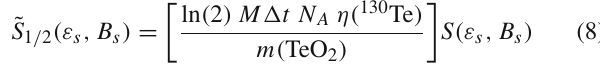
puted as exposure weighted mean for the cut and accidentals efficiency terms. All values are percentages, the uncertainty on the last digit